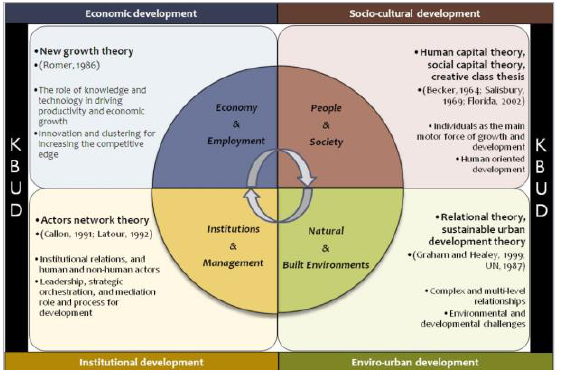
Figure 5 . Knowledge-based urban development